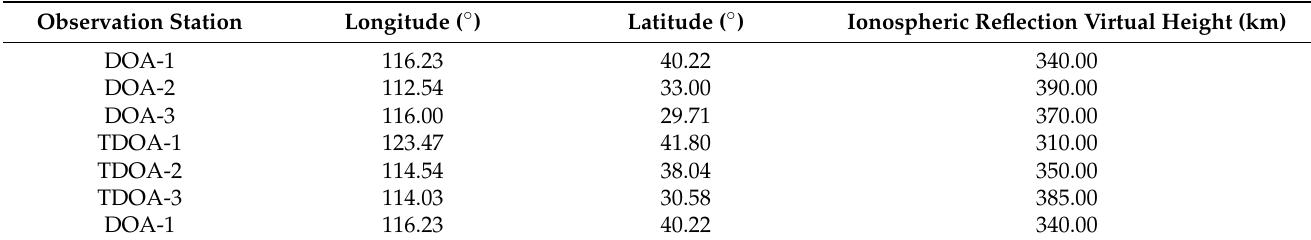
Table 1. Longitude, latitude, and ionospheric reflection virtual height of the observation